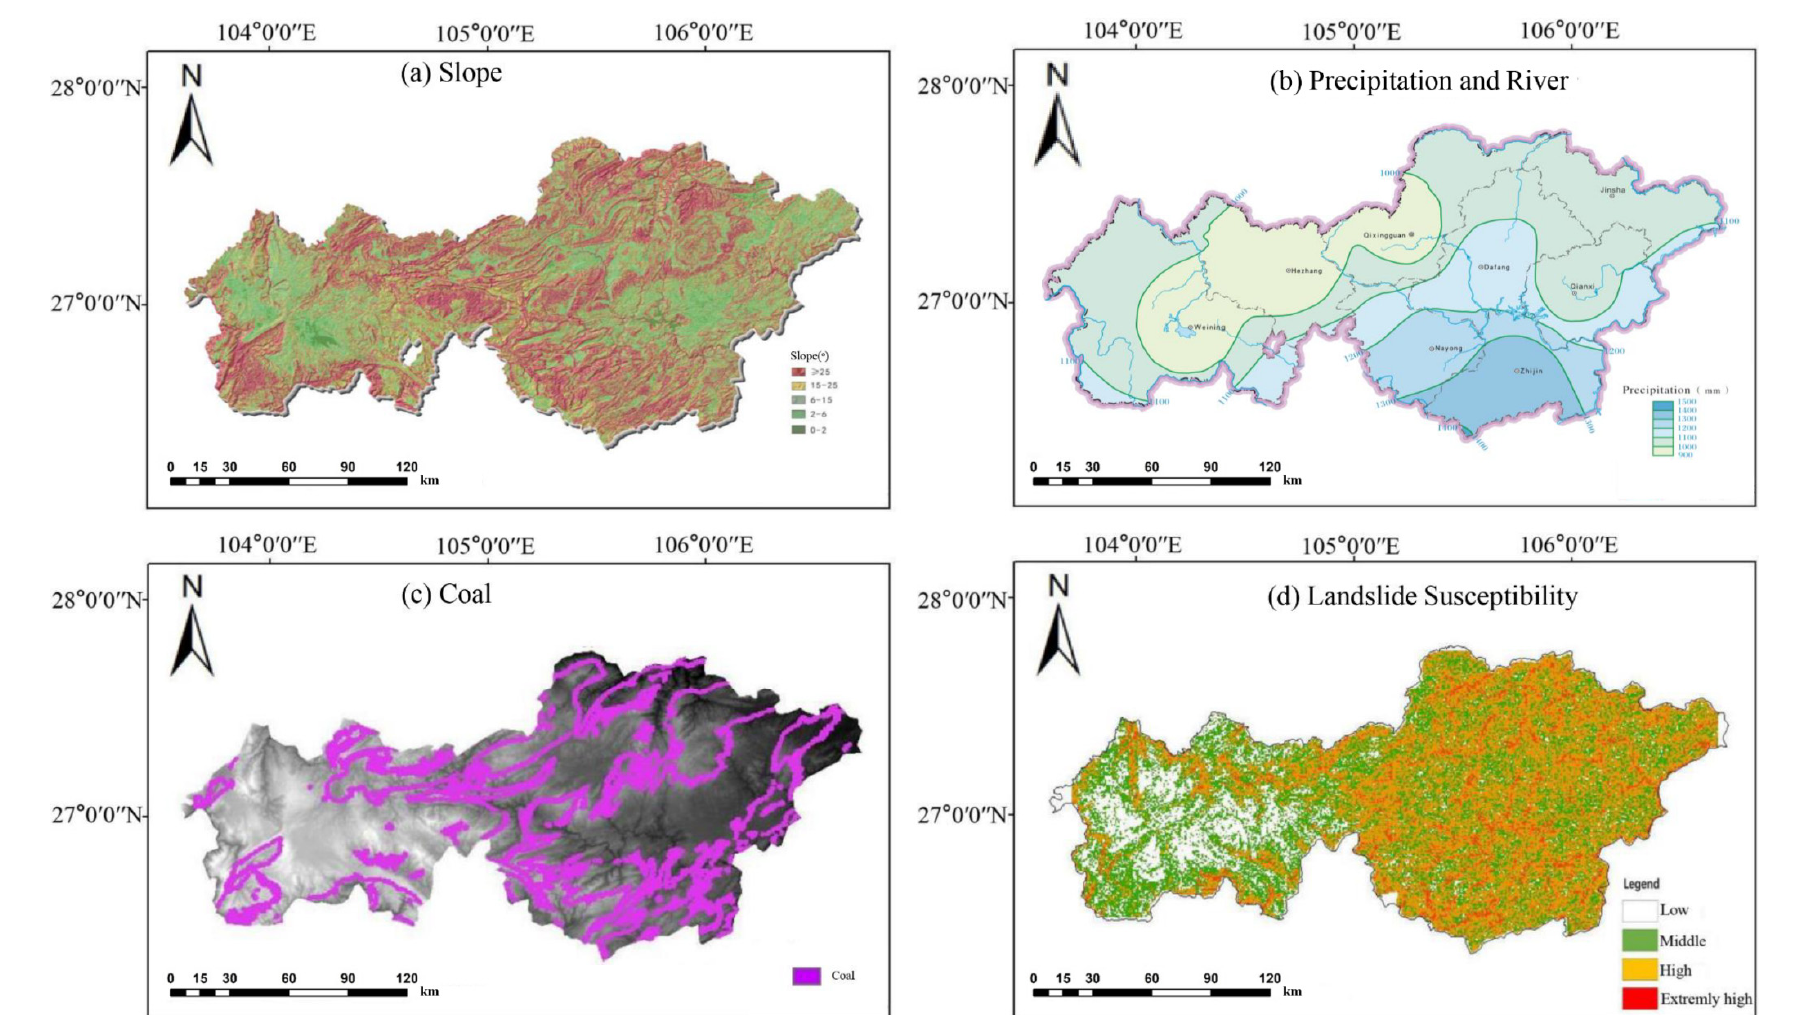
Figure 3. ( a ) The slope distribution of Bijie; ( b ) the precipitation and river distribution of Bijie; ( c ) the coal mine distribution of Bijie; ( d ) landslide susceptibility.